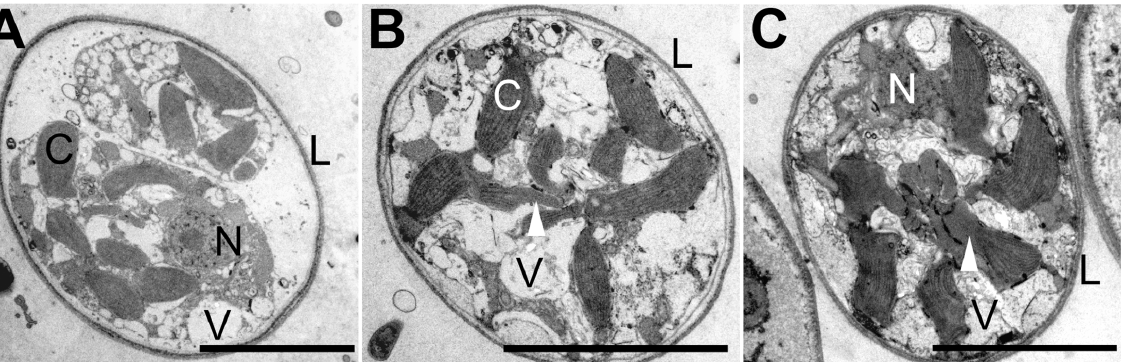
Fig 2. Arrangement of plastids in Guanchochroma wildpretii . (A) TEM of two amoebae in one multilayered lorica after binary division. The nucleolus is distinct within the nucleus. Vacuoles, mostly roundish, are present in different sizes. The plastids show no pyrenoids and are not interconnected. (B) TEM of an amoeba within a multilayered lorica. Vacuoles are present, yet with highly variable outline. Some plastids show terminal elongations without thylakoids (arrowhead). No Nucleus is visible in this section plane. (C) TEM of an amoeba within a multilayered lorica, showing four plastids and a nucleus without nucleolus in the section plane. Plastids possess tubular to globular shaped protrusions (white arrowhead) that group in the cell center (black arrowhead). The cytoplasm appears highly granular with variably shaped, non-globular vesicles. V — vesicle, N — nucleus, L — lorica, C chloroplast. Scale bars 5 μ